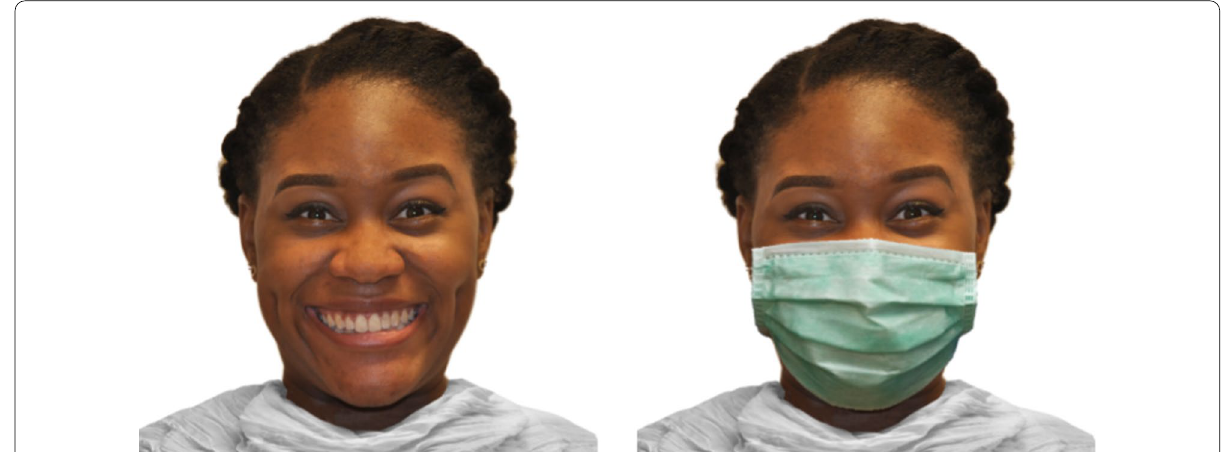
Fig. 1 Examples of unmasked (left) and masked (right) stimuli both expressing the emotion of